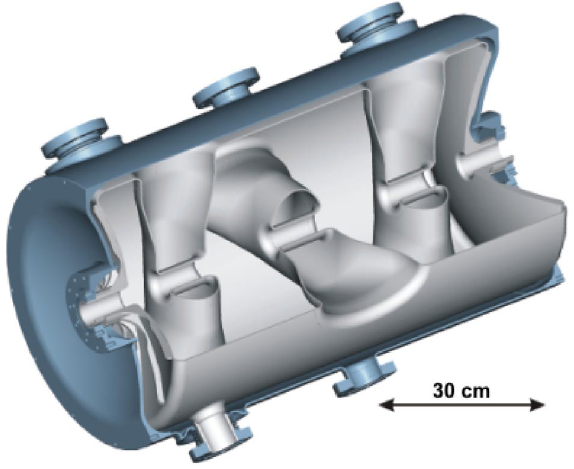
FIG. 1. (Color) Sectioned view of a 345 MHz triple-spoke- (cid:1) 0 : 50 . The niobium cavity shell is loaded cavity for (cid:3) GEOM nested in a stainless-steel jacket, which provides containment for 4.5 K liquid